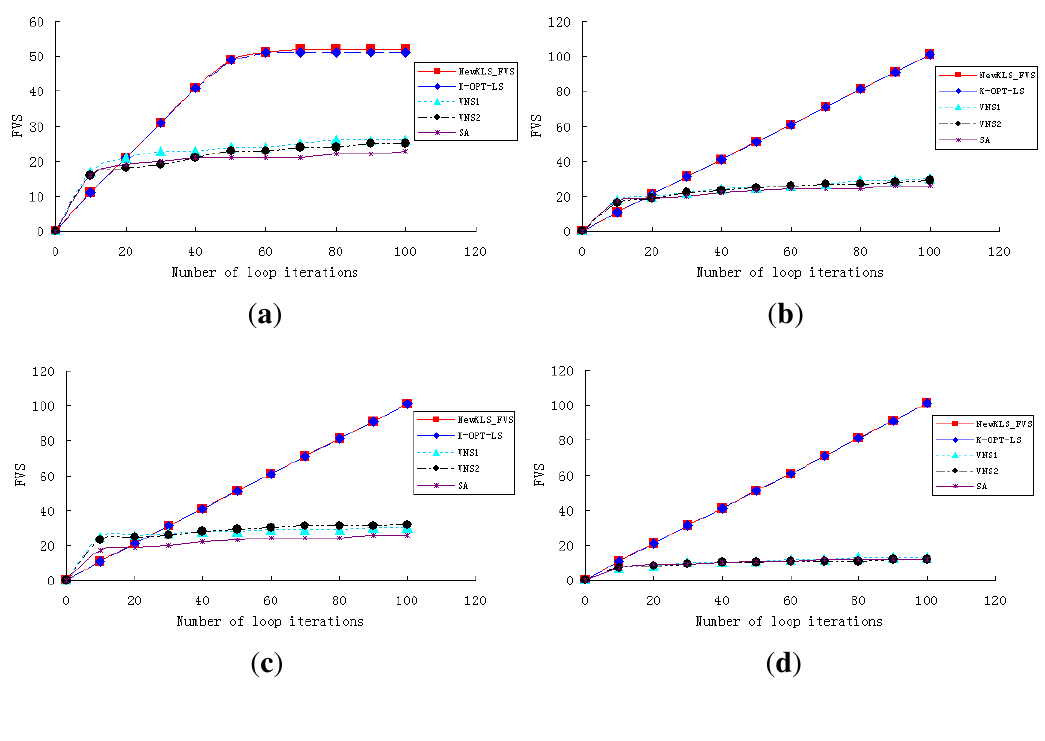
Figure 2. Comparison of the algorithms within 100 iterations. ( a ) huck.col; ( b )